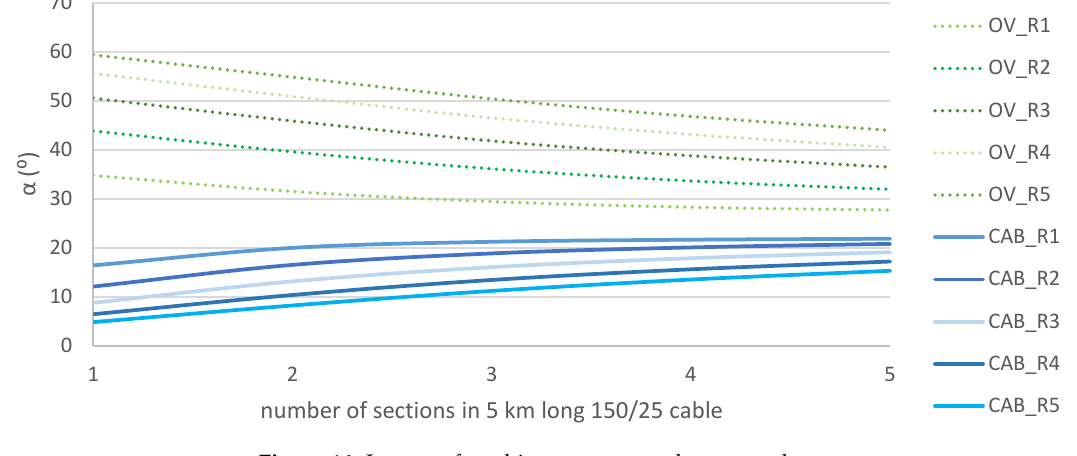
Figure 14. Impact of earthing system number on angle α .